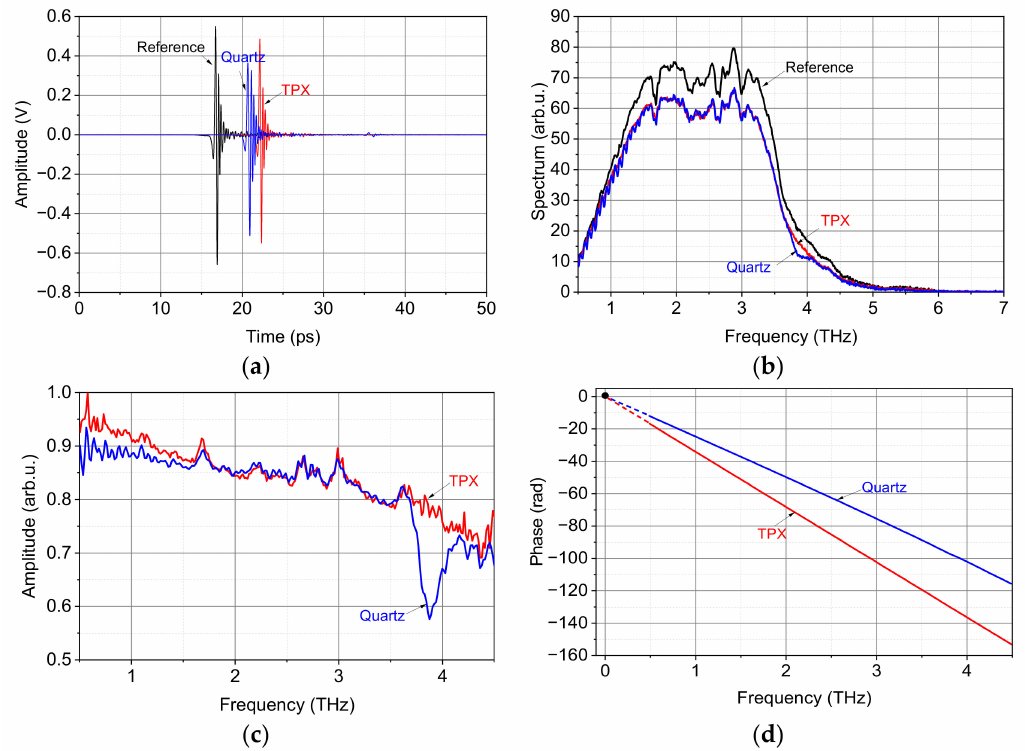
Figure 4. ( a ) Measured time domain signals of reference (black), TPX (red) and quartz (blue); ( b ) normalized transmission spectrum of reference (black), TPX (red) and quartz (blue); ( c ) amplitude of the transfer function of the two materials: TPX (red) and quartz (blue); ( d ) phase of the transfer function of the two materials: TPX (red) and quartz